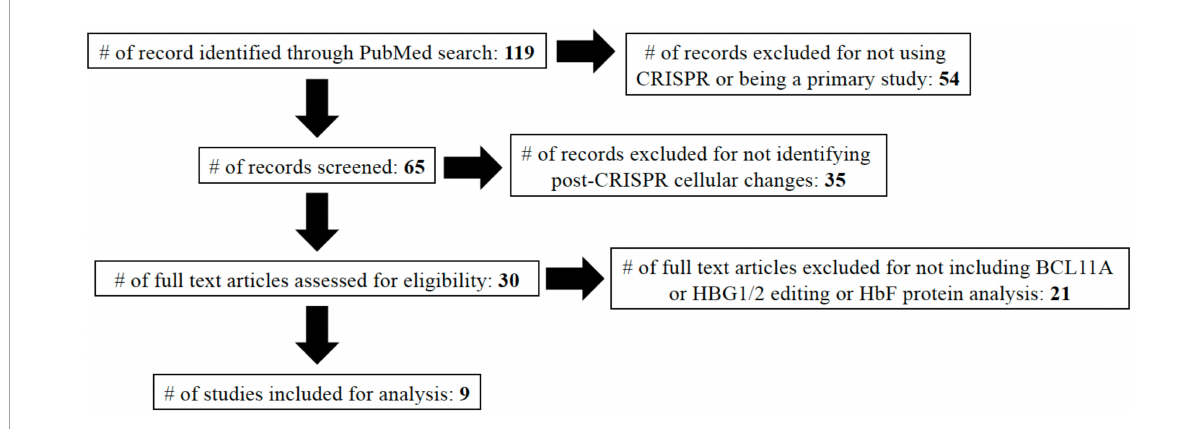
FIGURE2 PRISMA diagram. In total, 119 studies were identified using the search terms: “ β -Thalassemia,” “beta-thal,” “sickle cell disease,” “SCD,” and “CRISPR.” Studies were then included/excluded based on described characteristics. The nine studies included in the study are referenced (13, 17–19, 25, 30–33).